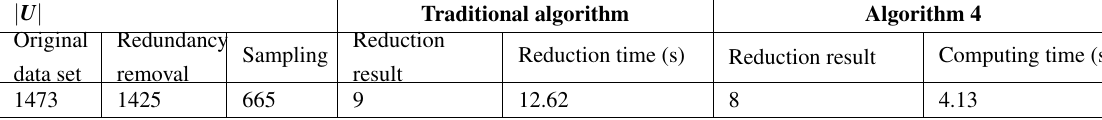
Table 6 Comparison on the effect of reduction for Contraceptive data